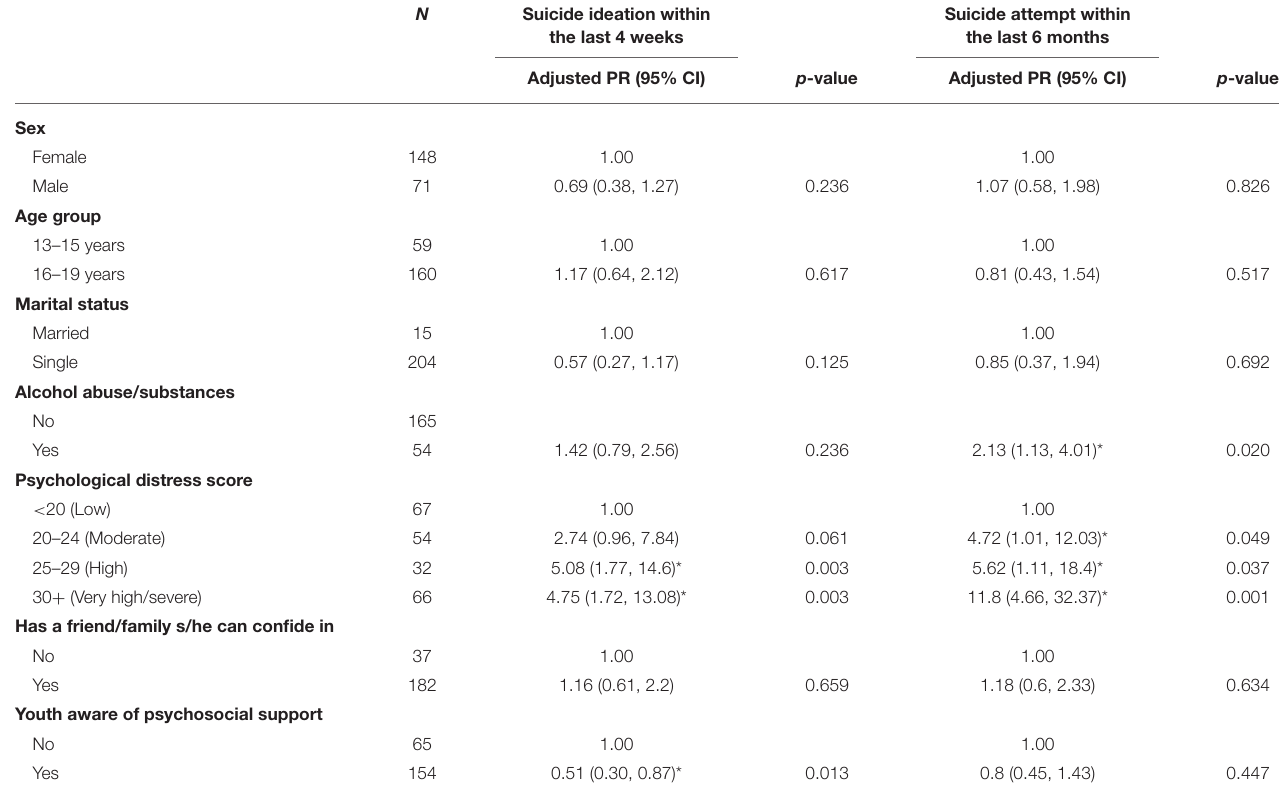
TABLE 3 | Multivariate analysis of factors associated with suicide ideation and suicide